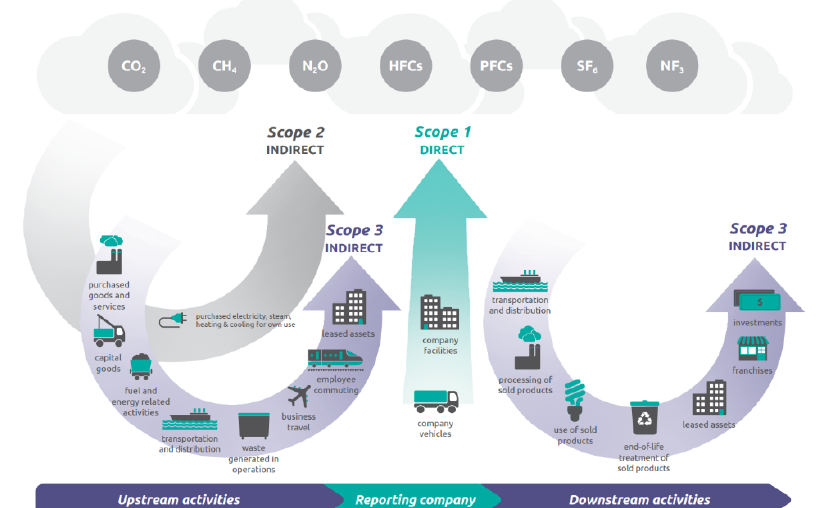
Figure 1. Graphical representation of scope 1, 2 and